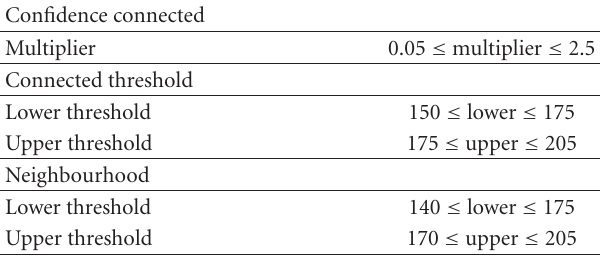
Figure 5: (L1) multiplier = 2 . 5, (M1) multiplier = 2 . 0, (N1) multiplier = 1 . 5, (O1) multiplier = 1 . 0, (P1) lower = 140, upper = 170, (Q1) lower = 150, upper = 180, (R1) lower = 155, upper = 190, (S1) lower = 160, upper = 195 are (xi) values set for the contrecoup contusion by confidence connected, for (xii) contrecoup contusion by neighbourhood